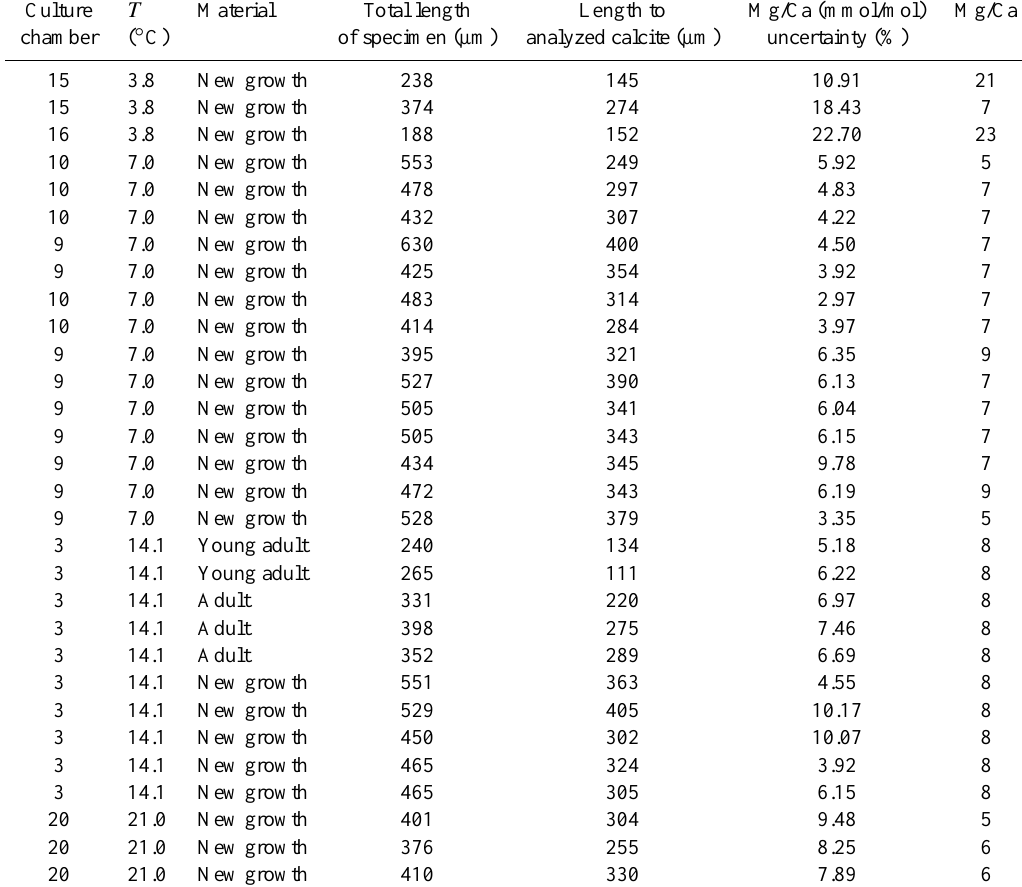
Table 5. Mg/Ca data for the calcite precipitated during the experiment presented for each temperature and analyzed material (new growth; young adults and adults) together with specimen length and length to LA